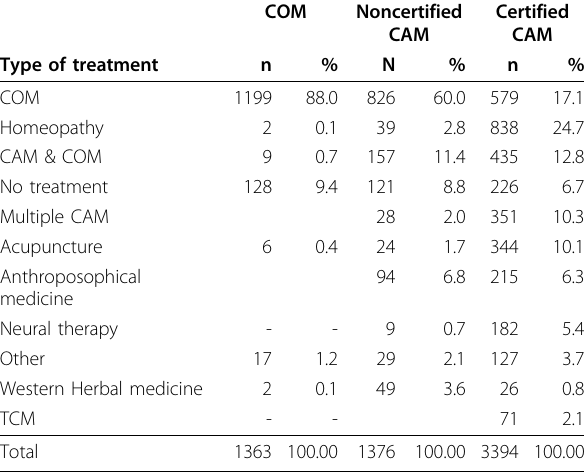
Table 2 Distribution of therapeutic procedures